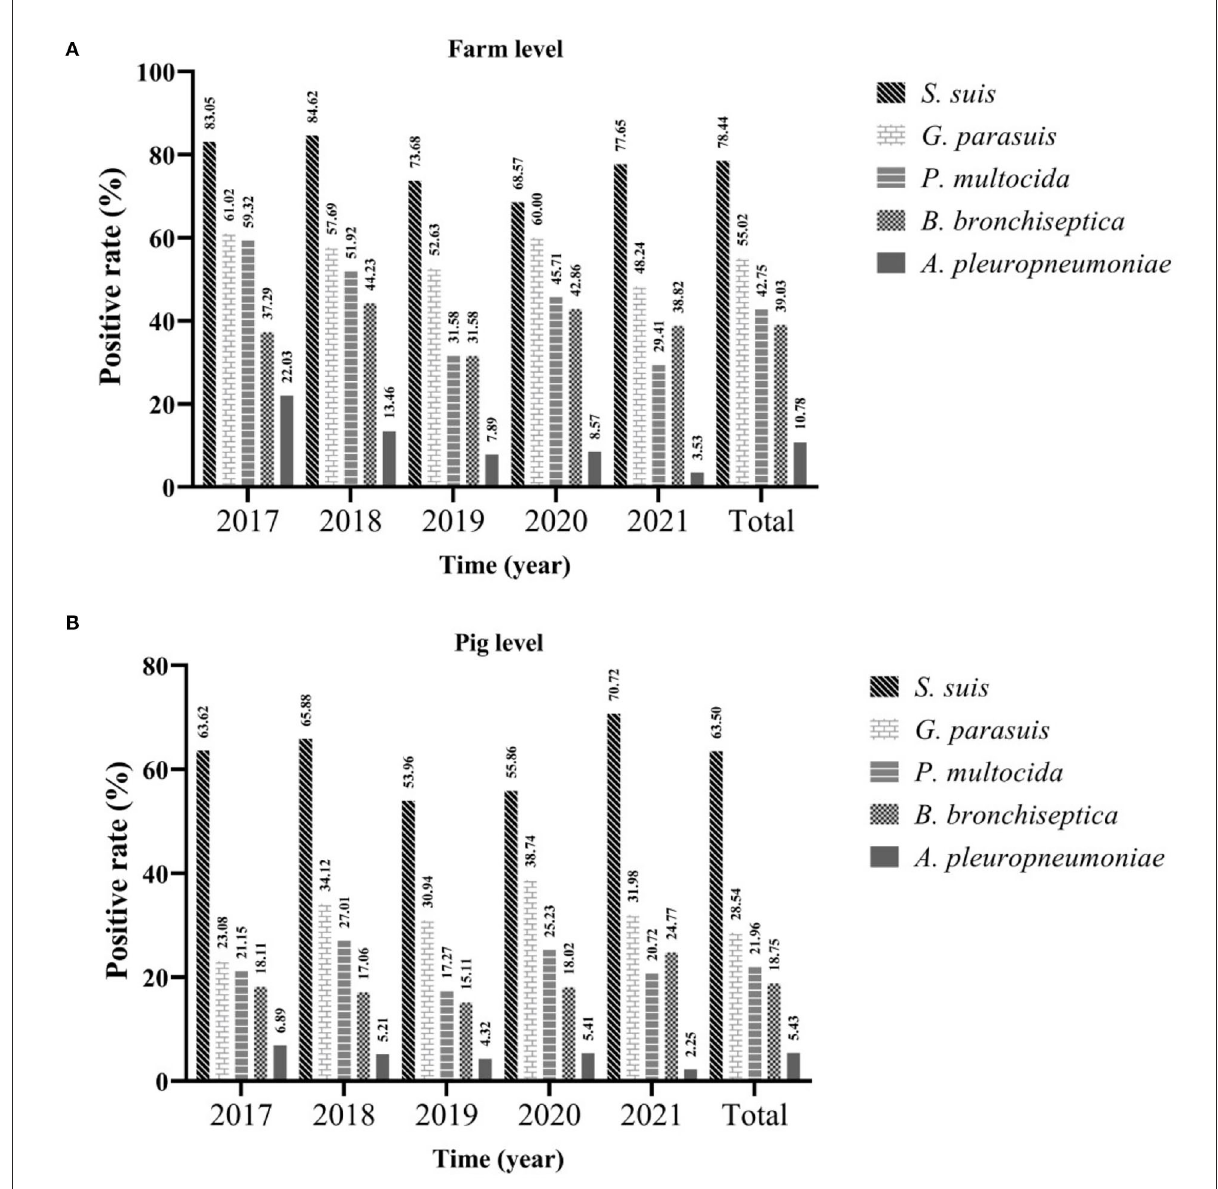
FIGURE2 The positive rate of different bacteria from 2017 to 2021. Farm level (A) and pig level (B) .